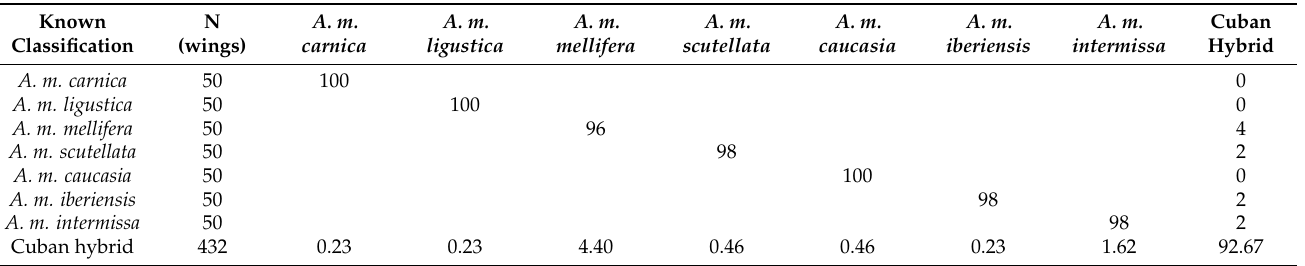
Table 1. Frequency of bees (wings) of the centers for rearing queens based on the pure subspecies of Apis mellifera .